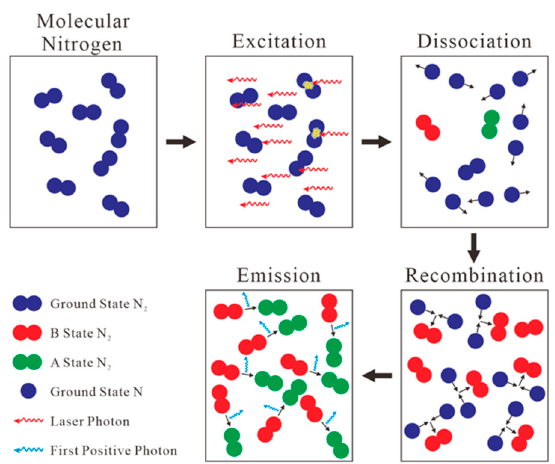
Figure 7. Diagram of the femtosecond laser electronic excitation tagging velocimetry (FLEET) nitrogen tagging mechanism. The incident 100 fs laser dissociates the nitrogen molecules into atoms, which subsequently recombine into the excited B state of molecular nitrogen, which emits in the red and near infrared through the first positive transition to the A state.